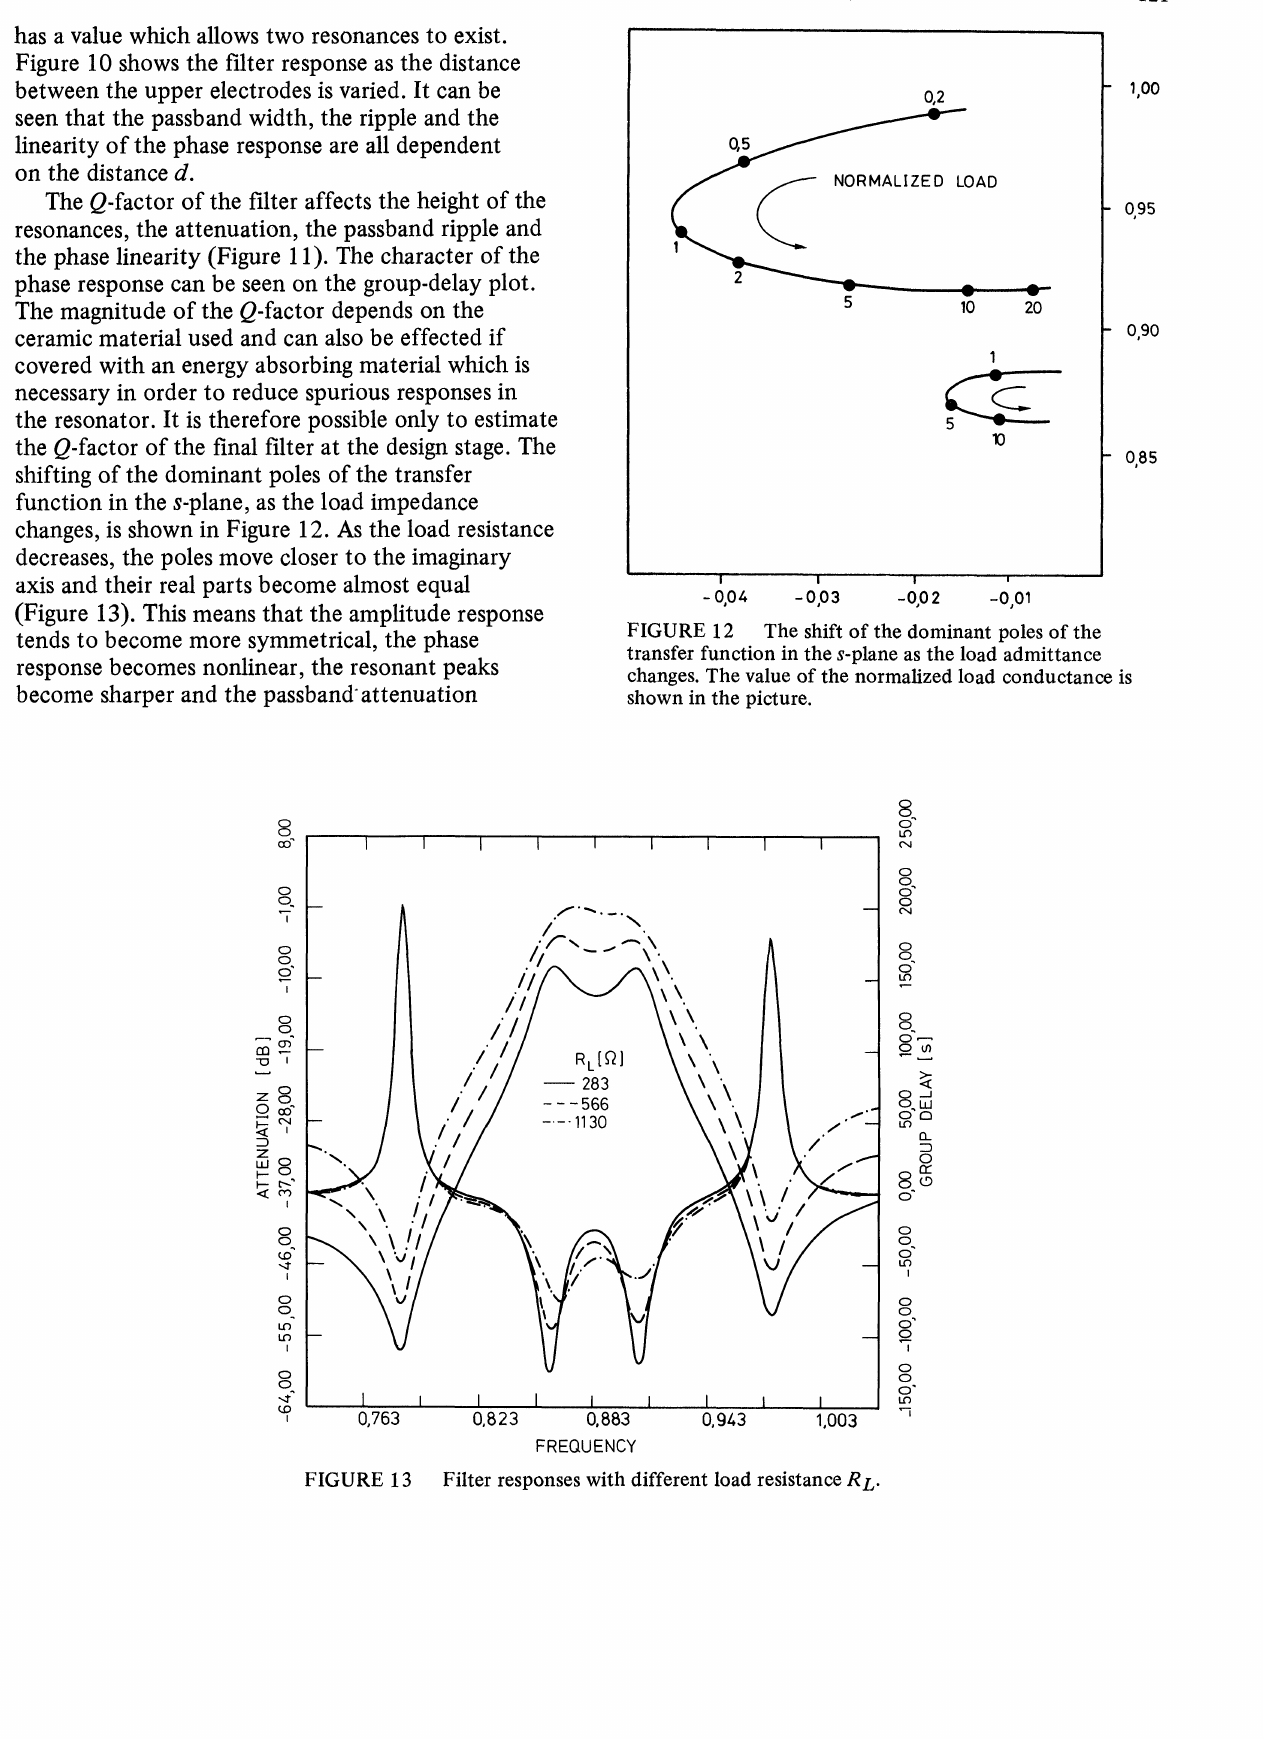
Filter responses with different load resistance R